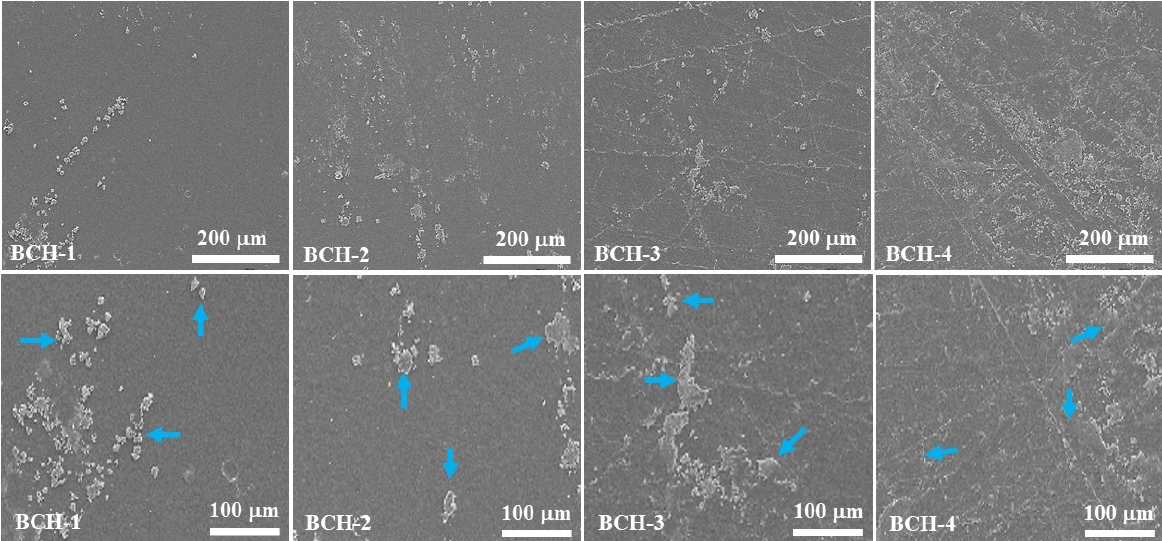
Figure 3. SEM micrographs of all samples of biocomposite hydrogels and in the first row, the SEM micrographs were captured at magnifications (200 at 100 μ m). The blue arrows in the second-row present flakes of rGO, causing rough surface morphology.